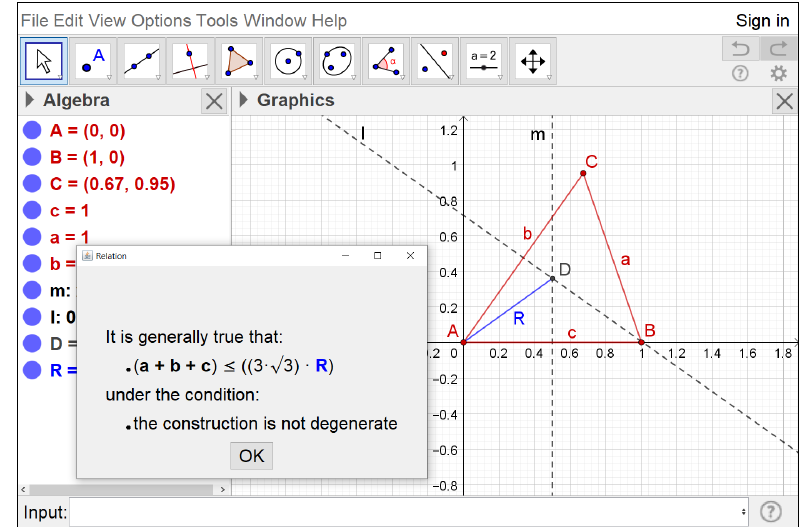
Figure 10. Numerical output of the Relation tool.